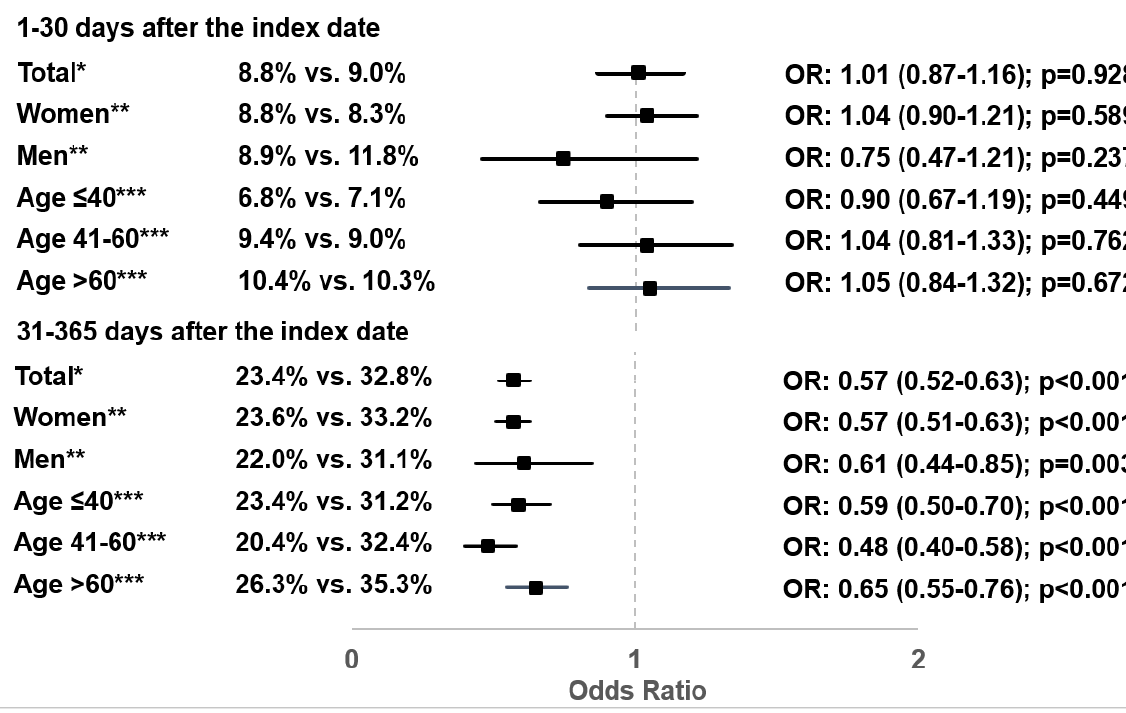
Figure 5. Association between Canephron ® prescription and probability of antibiotic prescription 31–365 days or 1–30 days after the index date (Canephron ® versus antibiotic). * Multivariable logistic regression adjusted for age, sex, health insurance coverage, practice specialty, and CCI. ** Multivariable logistic regression adjusted for age, health insurance coverage, practice specialty, and CCI. *** Multivariable logistic regression adjusted for sex, health insurance coverage, practice specialty, and CCI.